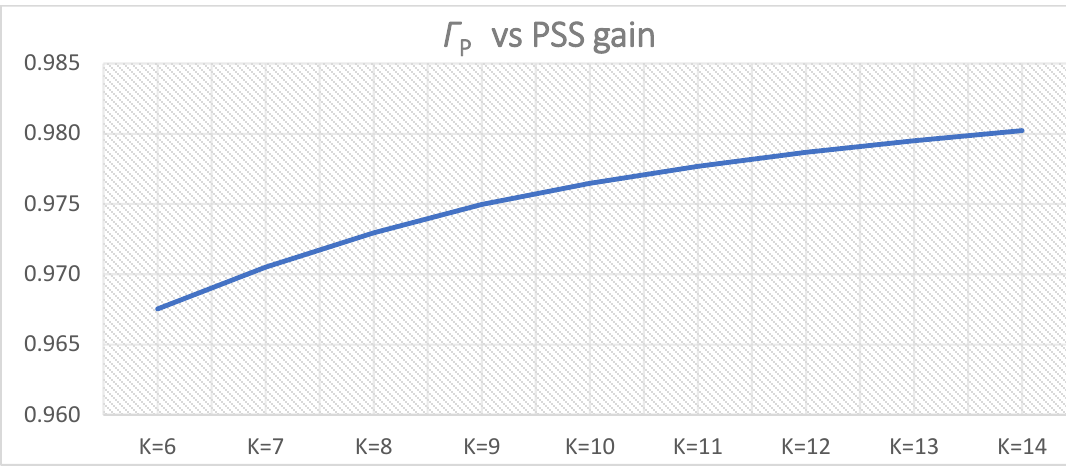
Figure 21. Γ δ ( Γ δi,l 1 and Γ δi,u 1 from Table 7 and Table 8) for PSS parameters T = 0.5 s, K = 6 – 14.